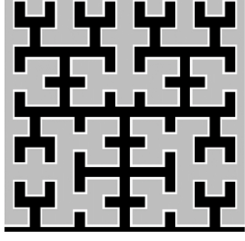
Figure 3. Schematic of a fractal capacitor.